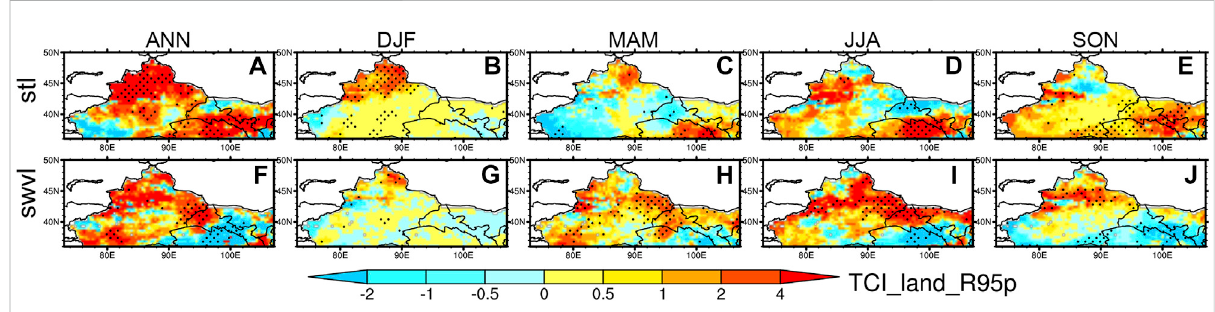
FIGURE 6 Spatialdistributionsoftheannualandseasonalcouplingindexofstl1andswvl1withR95P.Theblackdotsarethegridsthatpassedthe0.05level signi fi cance test.